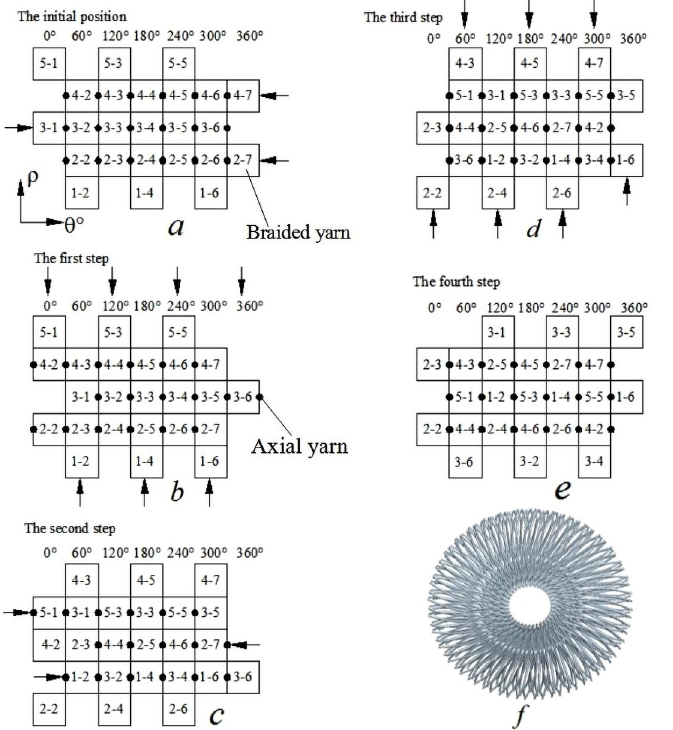
Fig 1. Principle of 3D circular